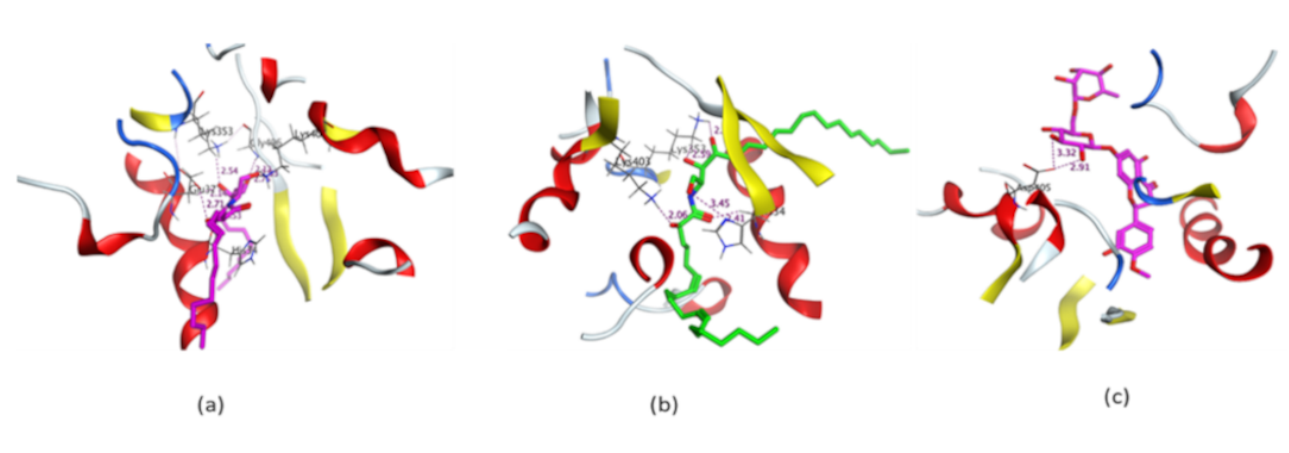
Figure 3. 3D representation of the docking of compounds Cer-5 ( a ); Cer-4 ( b ); and hesperidin ( c ) into the SARS-CoV-2 spike binding site with